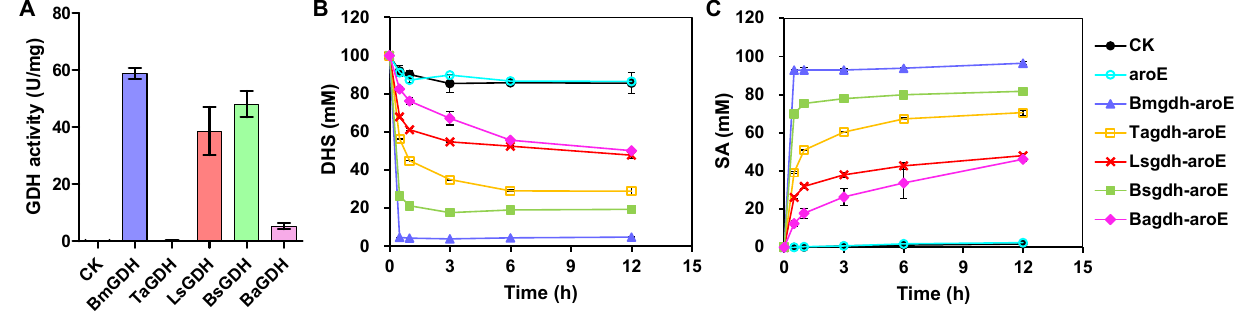
Figure 2. The effects of different GDHs on catalytic efficiencies of whole-cell biocatalysts. ( A ) GDH activities in the cell-free extracts of recombinant strains; Bioconversion of DHS ( B ) to SA ( C ) by whole-cell biocatalysts with different GDH–AroE combinations. The BL21(DE3) strain transformed with empty pETDuet-1 plasmid was used as the negative control (CK). Reaction conditions: 100 mM sodium phosphate buffer (pH 7.0), 100 mM DHS, 150 mM glucose, 20 OD 600 whole-cell biocata- lyst, 10 mL of total volume, 37 ◦ C. Data are presented as the mean ± standard deviation of three independent